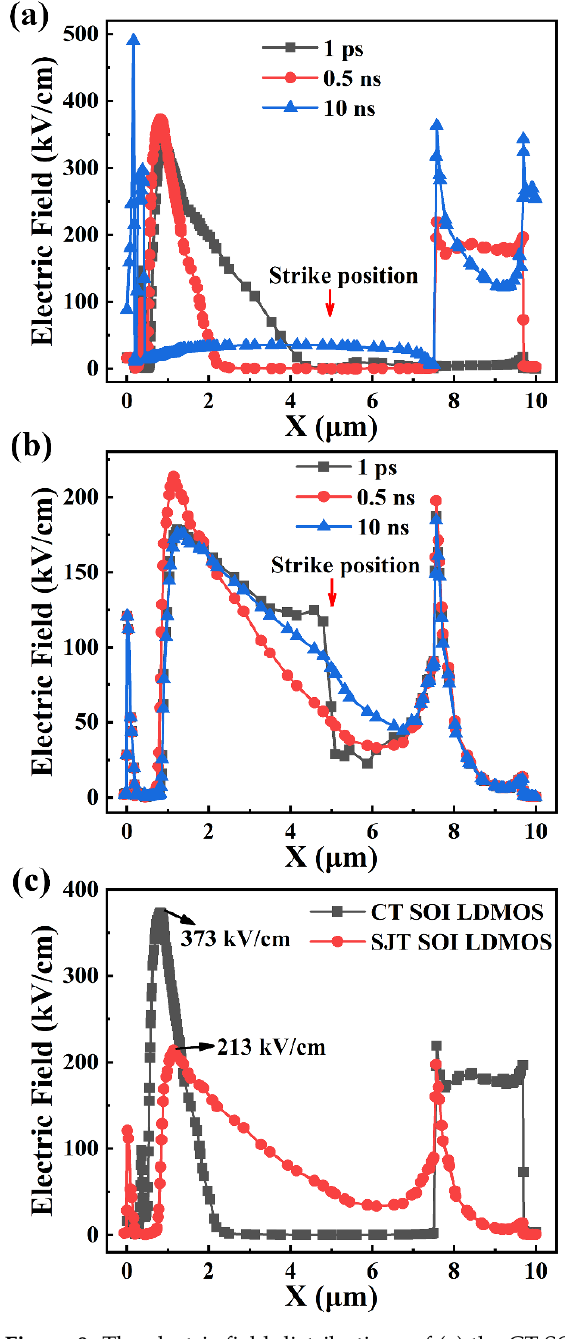
Figure 9. The electric field distributions of ( a ) the CT SOI LDMOS and ( b ) the SJT SOI LDMOS at different times after heavy ions with LET of 1 pC/ µ m strike at Position E when V DS is set as 58 V, ( c ) the electric field distributions of the SJT SOI LDMOS and CT SOI LDMOS at time of 0.5 ns after heavy ion incidence.